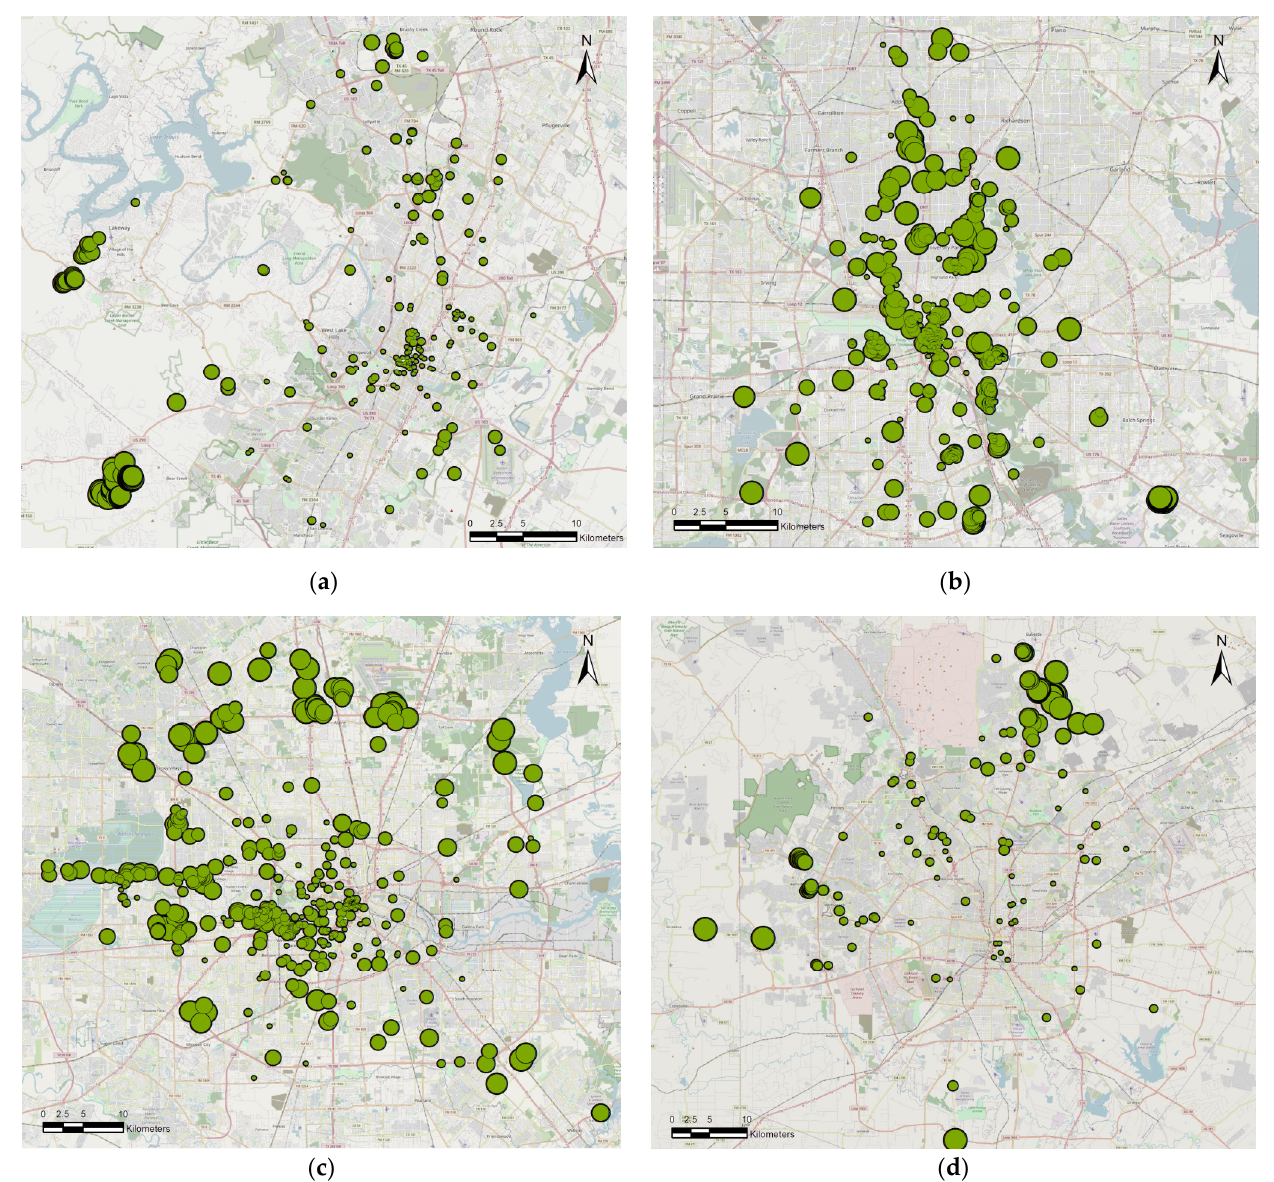
Figure 8. Accessibility of green spaces for green buildings in Texas by visualization.